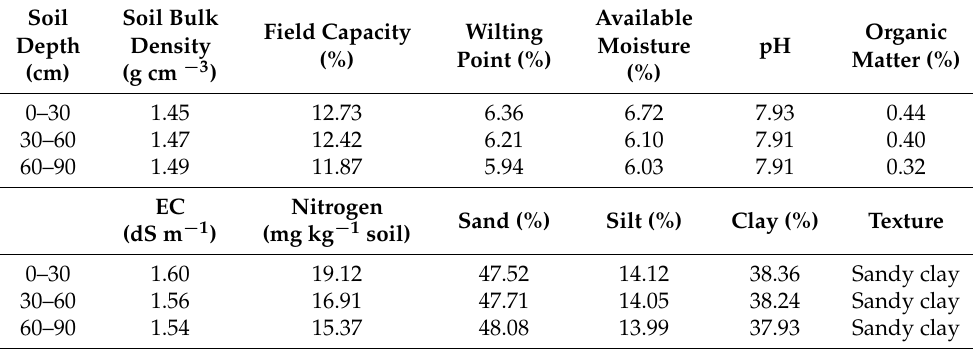
Table 2. Soil properties of the experimental site (over two seasons 2018 and 2019). Soil